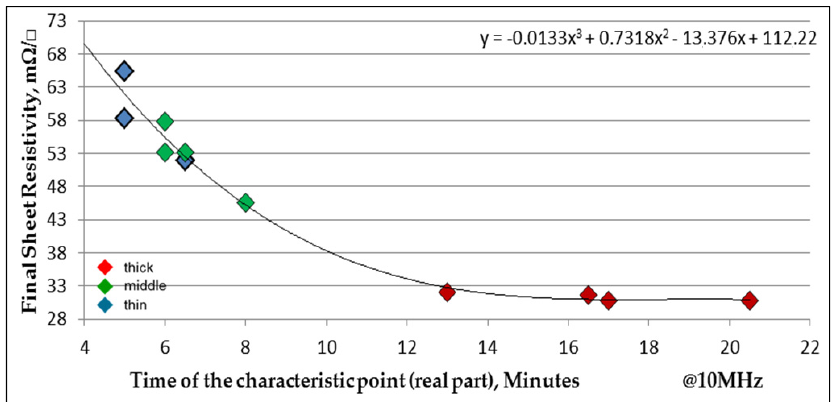
Figure 13. Correlations between the final sheet resistivity and the time of characteristic point at a frequency of 10 MHz for Cu/Ag films on ceramic substrate with coated area of 2 cm × 2 cm.